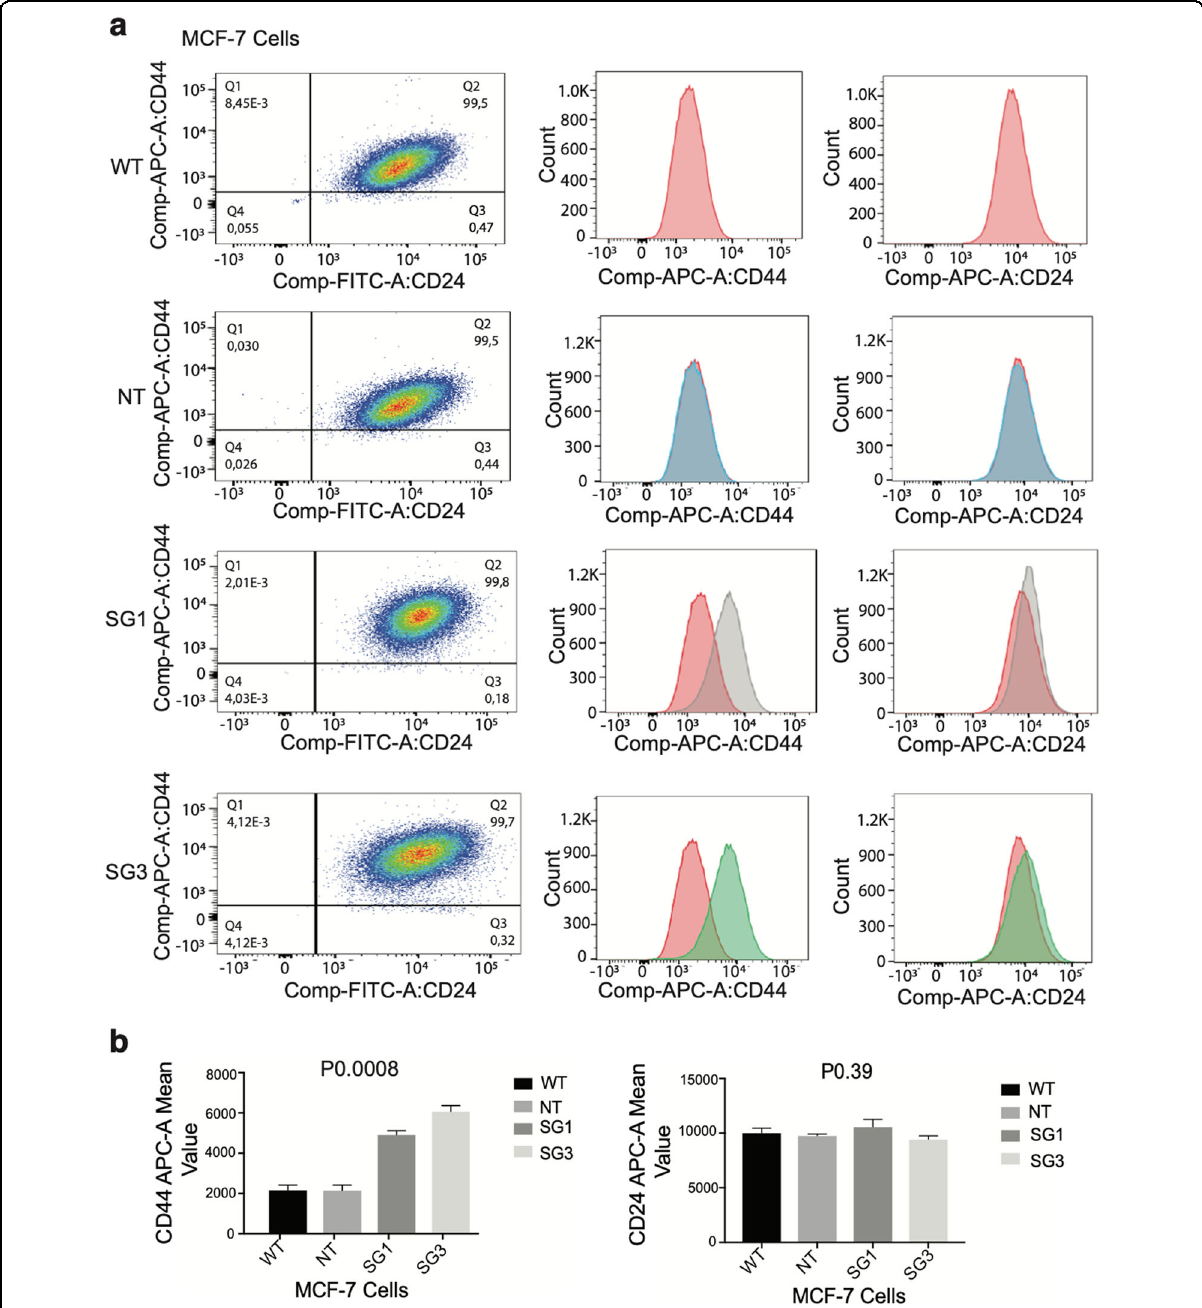
Fig. 3 Interfering with PRLR expression in MCF-7 breast cancer cells enriched for CD44 BCSC marker expression. a Content of CD44 + -BCSCs in MCF-7/WT, MCF-7/NT, and MCF-7/PRLRKO (SG1 and SG3) cell lines were determined by fl ow cytometry. Representative images of dot plot (left panels) and histograms of CD44 (middle panels) and CD24 (right panels) are shown. b Quanti fi cation analysis of BCSCs markers CD44 and CD24